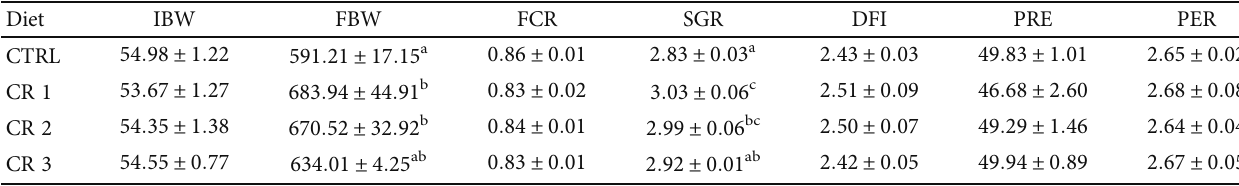
Table 5: Growth performance parameter of African cat fi sh after 84 days of feeding ( mean ± SD ).